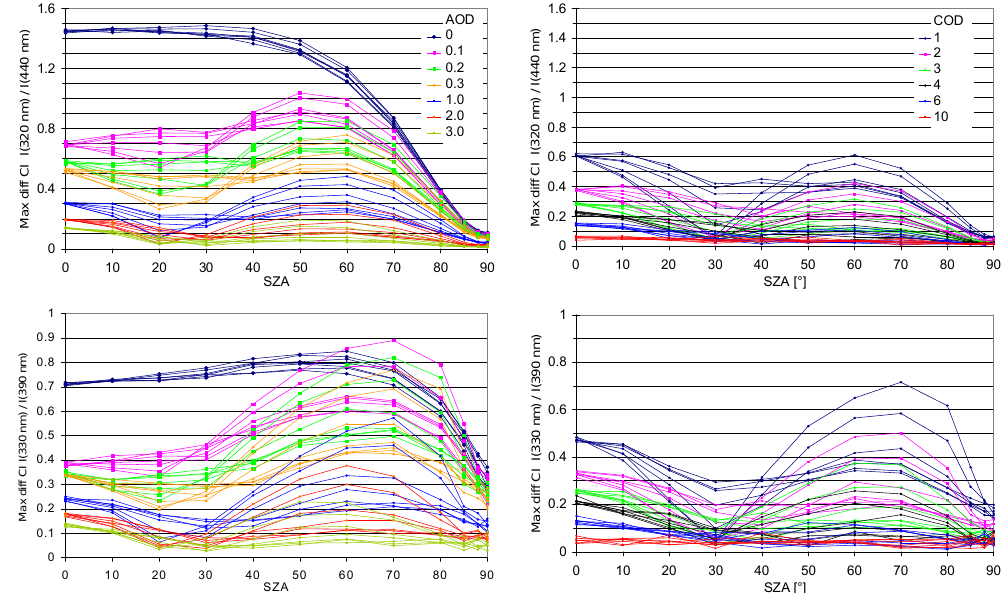
Figure 12. Spread of the CI (top: CI orig for 320nm/440nm; bottom: CI new for 330nm/390nm) between the different elevation angles for different aerosol (left) and cloud (right) scenarios. The spread is calculated as the difference between the maximum and minimum CI for a given combination of SZA and relative azimuth angle. The different lines of the same colour represent simulations for different relative azimuth angles (0, 30, 60, 90, 120, 150, 180 ◦ ). The simulations are made assuming an elevation angle of 85 ◦ for zenith view. Results for exact zenith view are almost identical (see Fig. A2 in the Appendix).